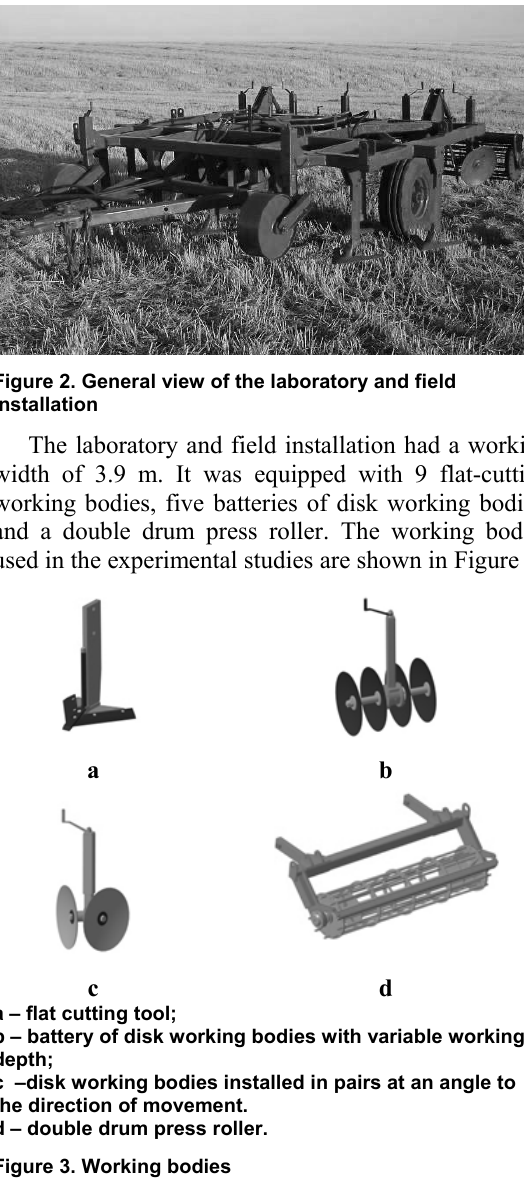
Figure 4. Electrical signals from the strain gauge link